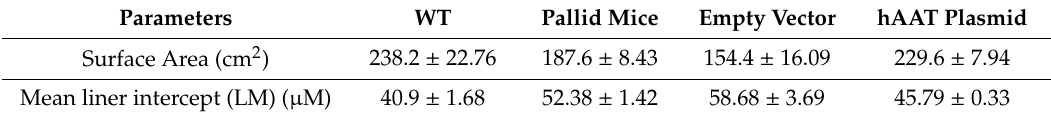
Figure 4. Lung morphometry: ( a ) septal surface area and ( b ) mean linear intercept (LM) in di ff erent experimental groups, as indicated. For each animal, the left lobe was analysed, and all parameters relate to this specific lobe. Statistical values are expressed as mean ± SD, unpaired t test was performed, and each group was compared to each other. * p < 0.05, ** p < 0.01. Table 2. Parameters for stereology (Figure 4): data are presented as mean ± SEM.